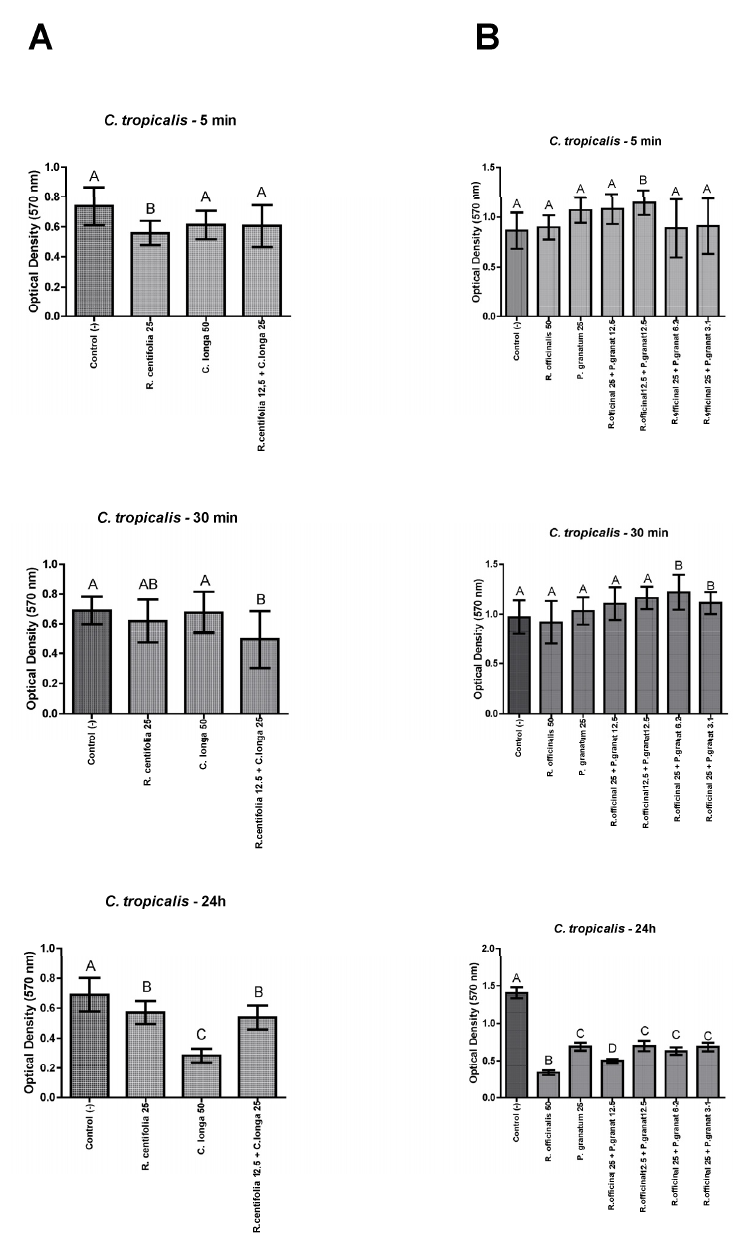
Figure 3. C. tropicalis biofilm load reduction after treatment with R. centifolia , C. longa , R. officinalis , and P. granatum glycolic extracts, and their combinations, for 5 min, 30 min, and 24 h. Legend: Different upper-case letters indicate a statistically significant difference.